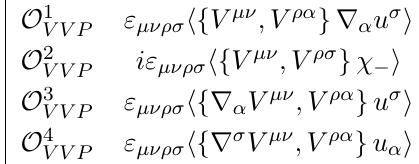
Table 3 . Full list of O j operators [66], containing those ( j = 1 ; 2 ; 3) that contribute to V V P